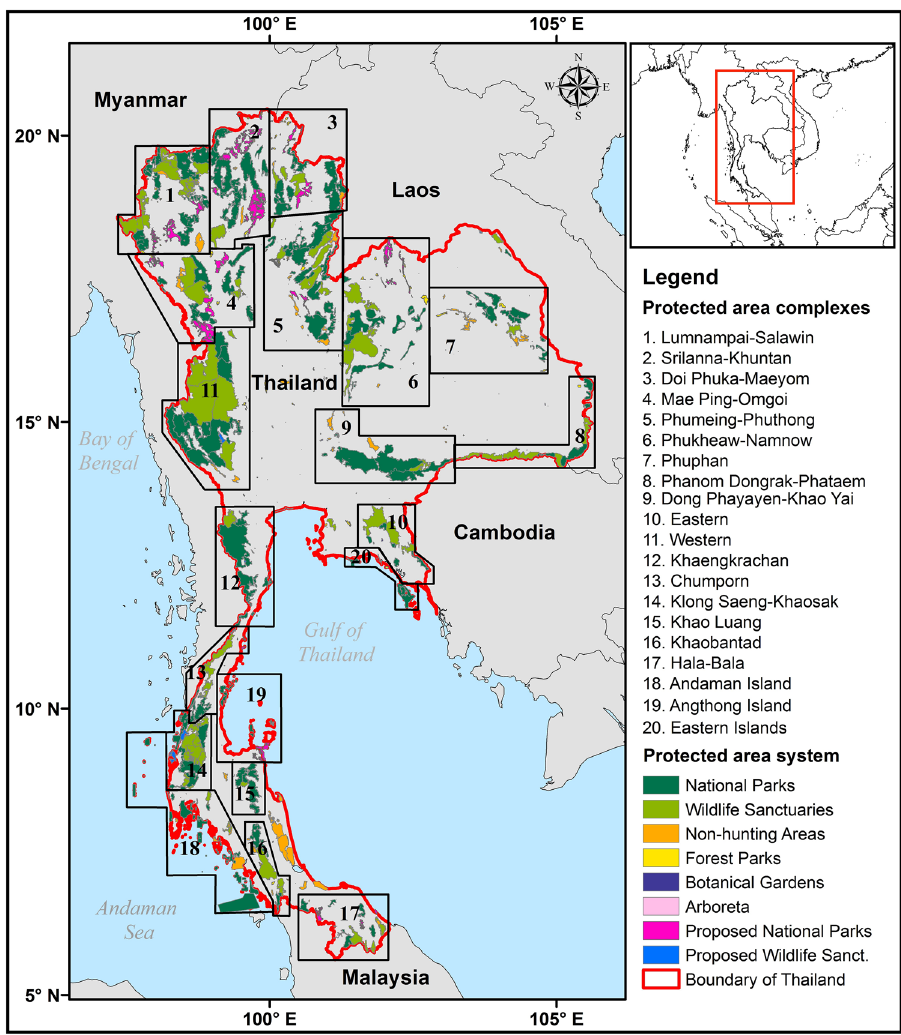
Figure 1. Thailand: location and protected area system, showing the protected area complexes used for management (DNP 2019). Maps created in ArcMap 10.5 (https:// suppo rt. esri. com/ en/ produ cts/ deskt op/ arcgis- deskt op/ arcmap/